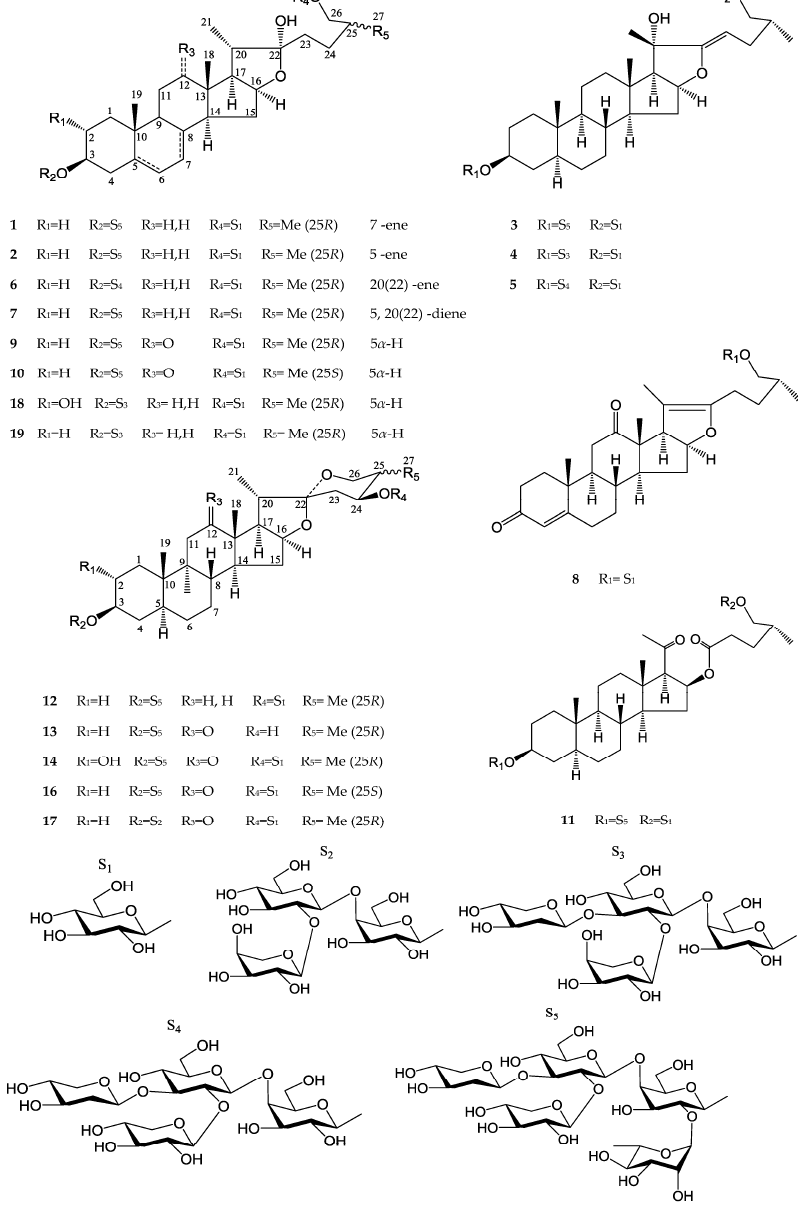
Figure 1. Steroidal saponins 1 – 19 isolated from Tribulus terrestris .